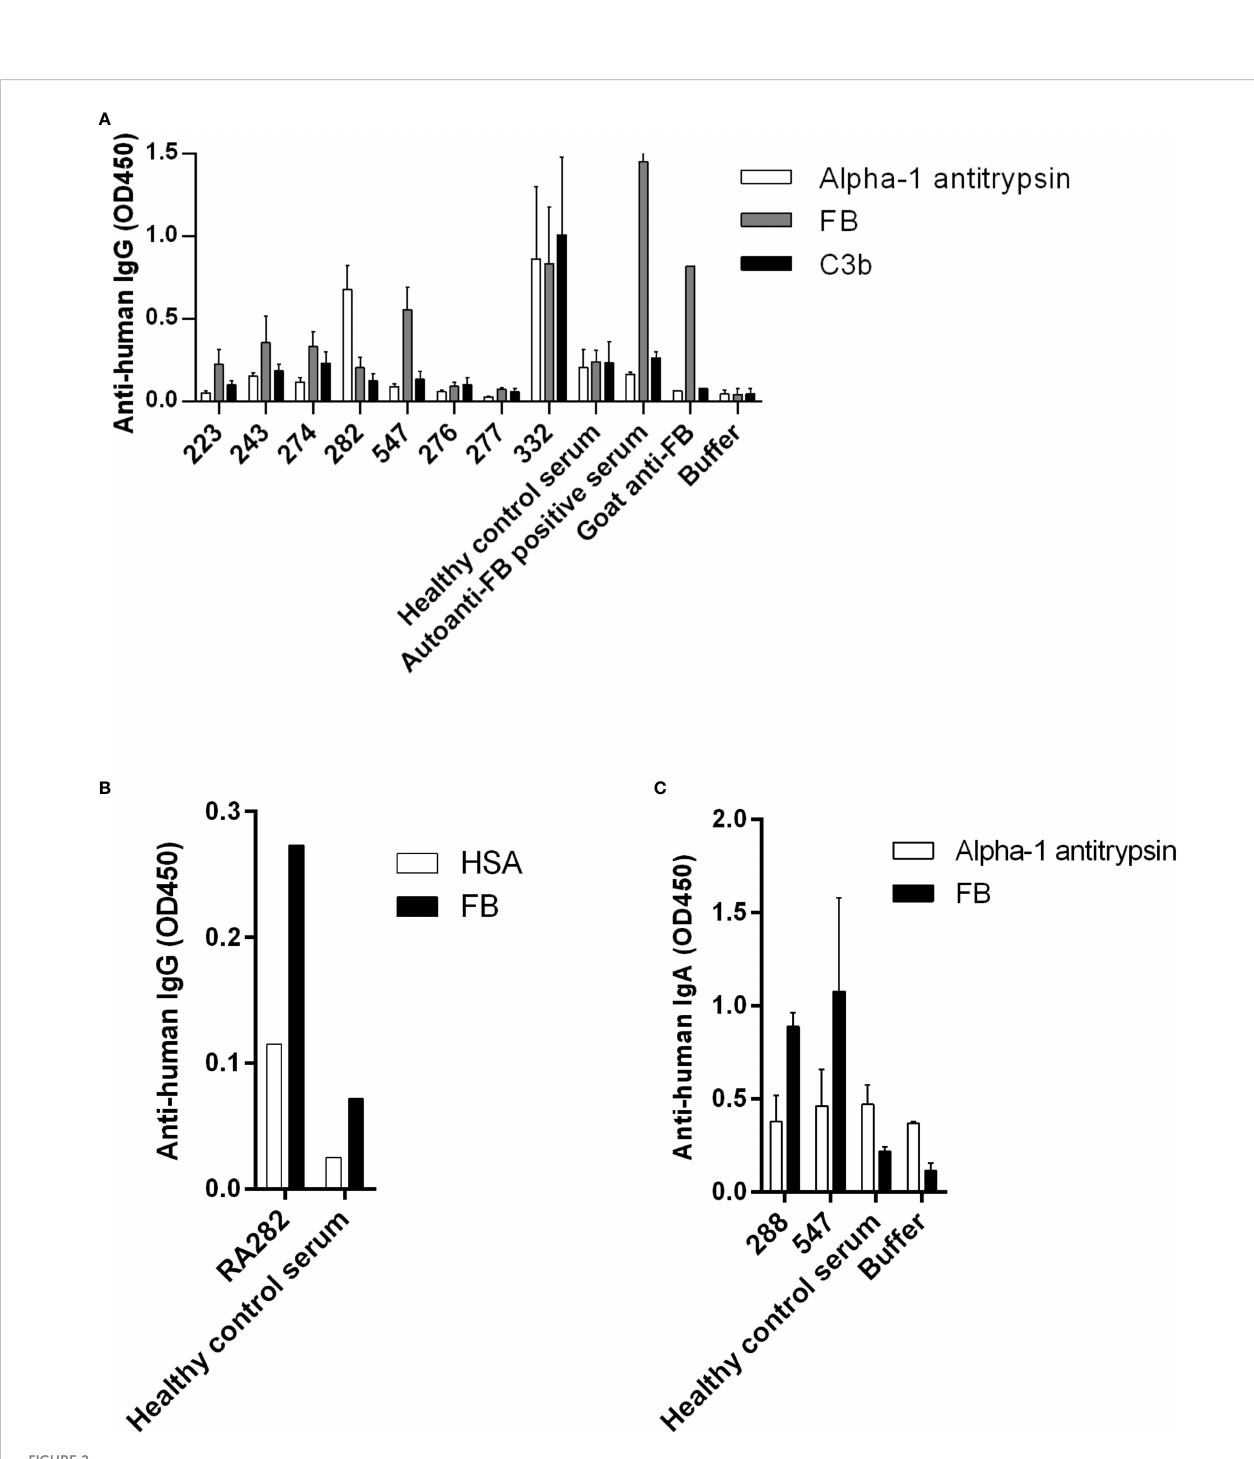
FIGURE 2 Autoanti-FB in RA patients. (A) FB, C3b and alpha-1 antitrypsin as negative control were immobilized on microtiter plate wells. After blocking, serum samples diluted 1:50 were added. Bound IgG was detected by HRP-conjugated anti-human IgG. Data are mean ± SEM of three experiments. (B) RA282 autoanti-FB was analyzed and con fi rmed using another negative control protein, human serum albumin (HSA). Data from a single experiment are shown. (C) IgA autoantibodies against FB were detected using HRP-conjugated anti-human IgA. Data are mean ± SD of two experiments. In all three panels selected samples are shown: positive patient samples, some negative patient samples and controls. For full datasets please refer to Supplementary Figure